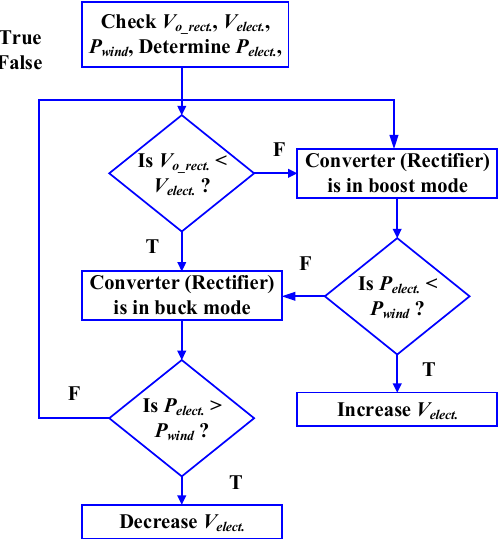
Figure 3. Flowchart of power control for electrolyzer.